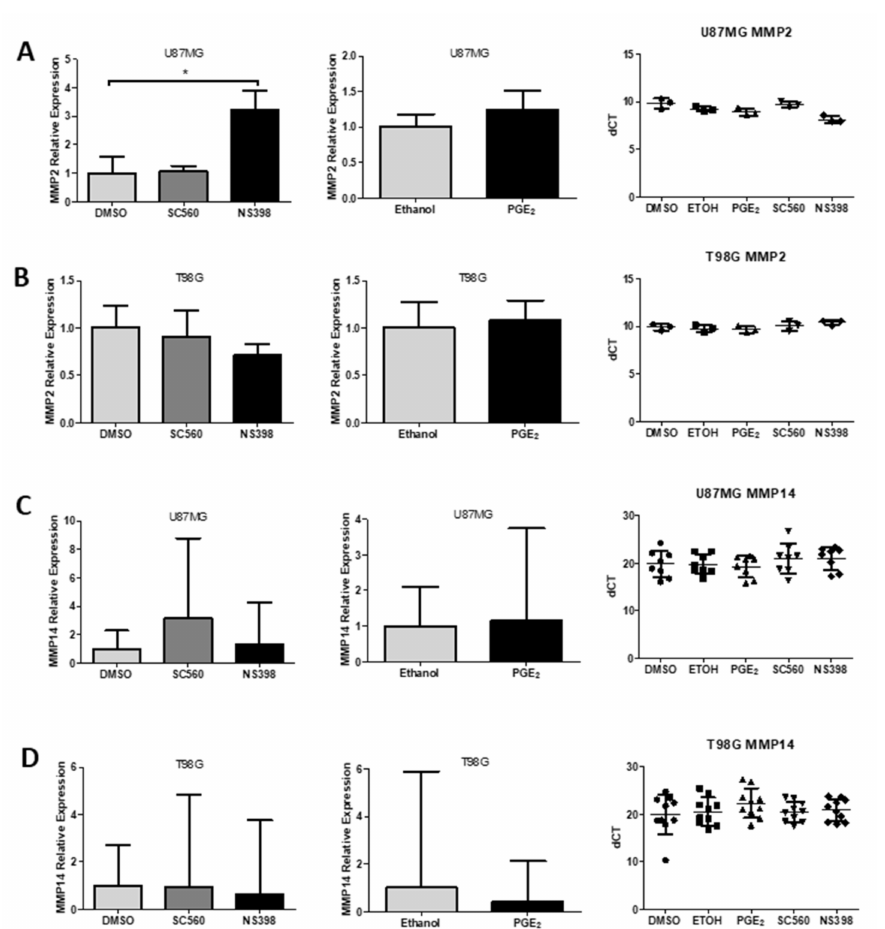
Figure 10. Effects of COX inhibitors on MMP2 and MMP14 mRNA expression in GBM cells. Cells were treated with SC560 (50 µ M), NS398 (50 µ M) or PGE 2 (10 µ M) for 24 h and mRNA expression was determined by RT-qPCR ( A ) MMP2 gene expression in U87-MG ( B ) MMP2 gene expression in T98G ( C ) MMP14 gene expression in U87-MG ( D ) MMP14 gene expression in T98G. Relative expression was calculated using 2 − ∆∆ CT and dCT’s are also shown. Data are presented as mean + SEM, n = 3. One-way ANOVA or Student’s t -test were performed. Differences were considered significant at p < 0.05. * = p <